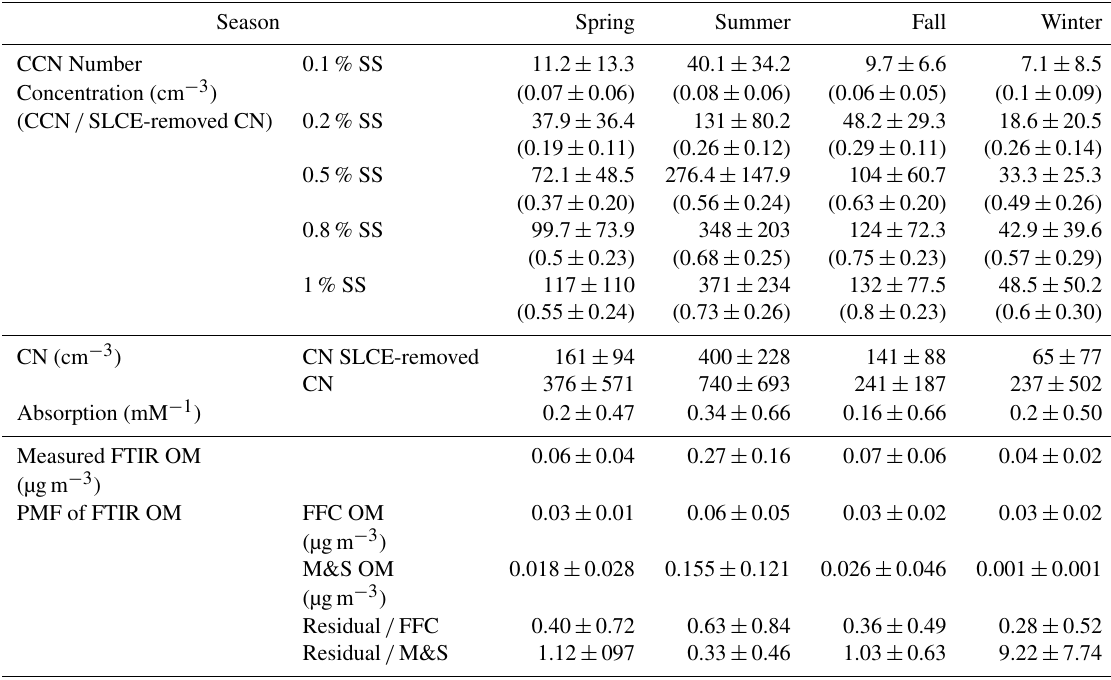
Table 1. Mean concentrations and ratios with standard deviations during 2016 at McMurdo. Season